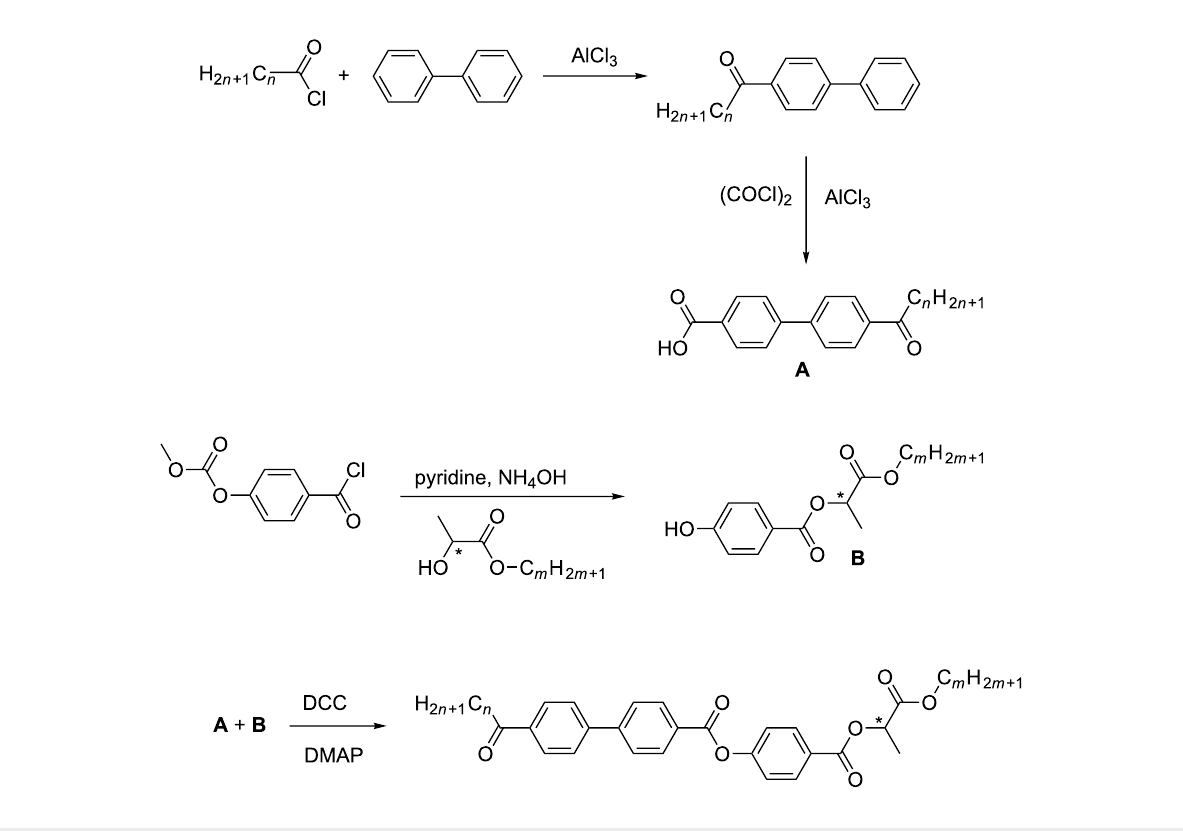
Scheme 1: Reaction scheme for the synthesis of new (S)-4-((1-alkoxy-1-oxopropan-2-yloxy)carbonyl)phenyl 4'-alkyloylbiphenyl-4-carboxylates denoted as KL n / m series.